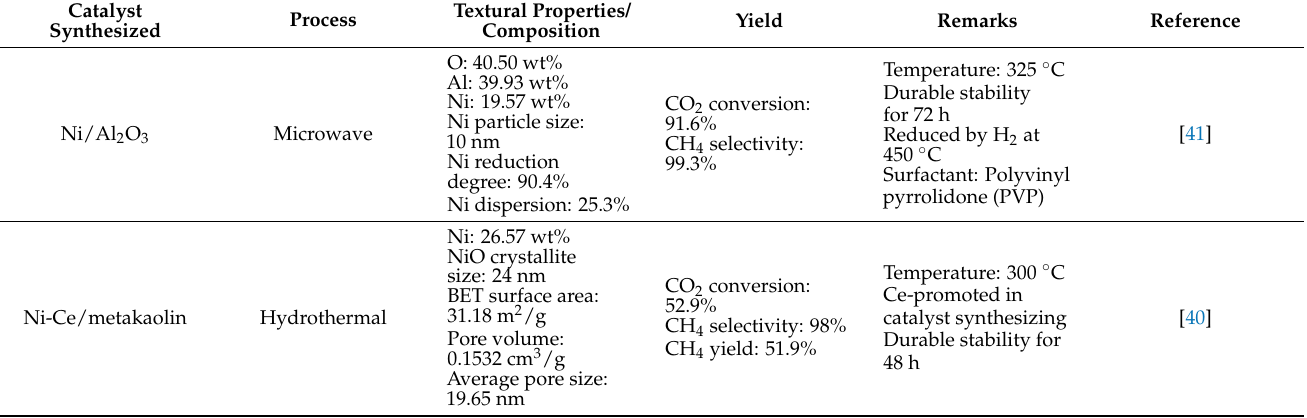
Table 5. Catalyst synthesized using microwave-assisted technologies for CO 2 methanation. Catalyst